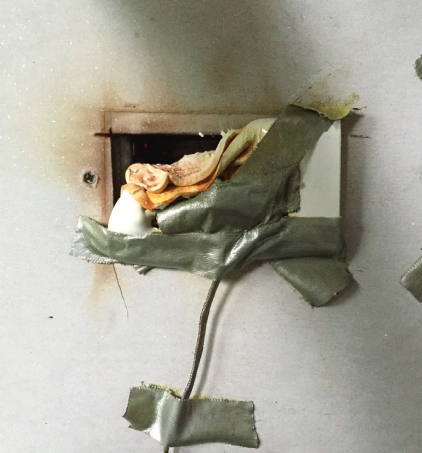
Figure 15: The external panel of the junction box softens at 28th minute in Test